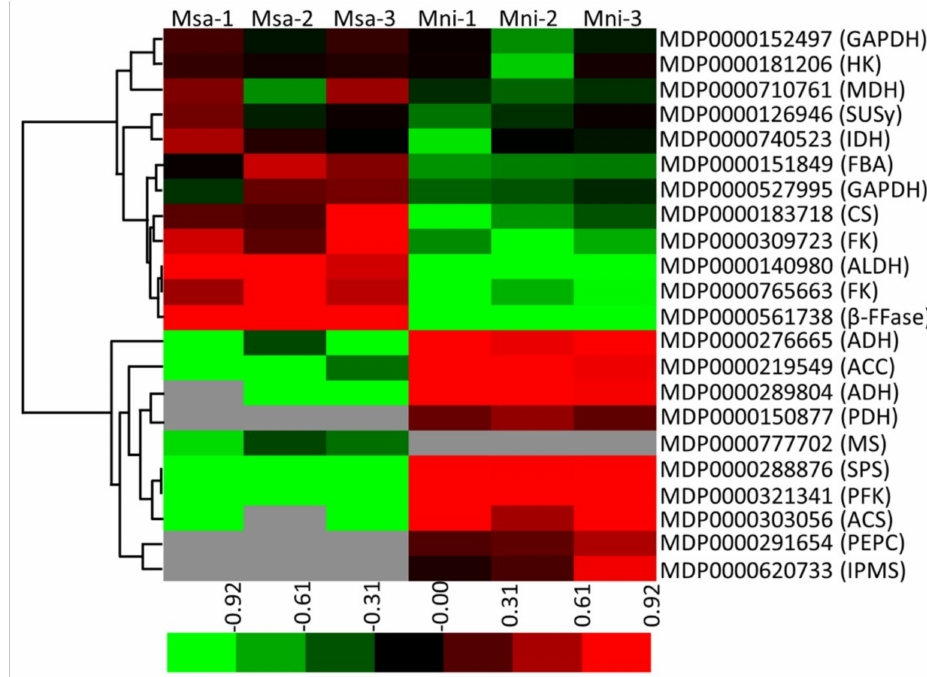
Figure 4. The di ff erentially-expressed proteins involved in soluble sugar and organic acid metabolism in two Malus species mature fruits. The heat map was constructed using Mev software based on relative levelsofdi ff erentially-expressedproteins, andnormalizedlog 2 -transformedvalueswereusedtoperform hierarchical clustering. Di ff erent colors represent di ff erentially-expressed protein levels. MS: